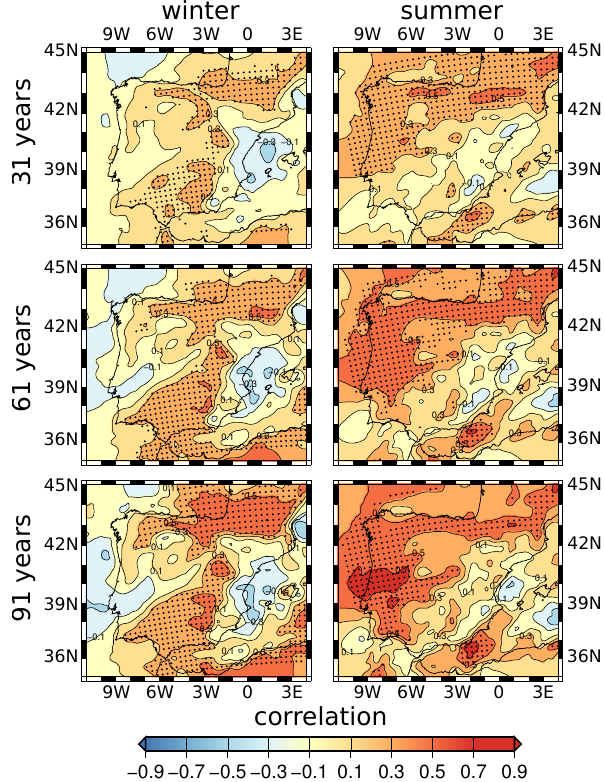
Fig. 3. Correlation map of precipitation series in winter (December–February, left column) and summer (June–August, right column) between the MM5-ERIK1 and MM5-ERIK2 exper- iments. The three rows represent the correlations performed with the series smoothed through a running mean of 31 (top), 61 (mid- dle) and 91 (bottom) years, respectively. Black circles denote grid points where the correlation is significant at the 95% confidence level according to a bootstrap method (Ebisuzaki,